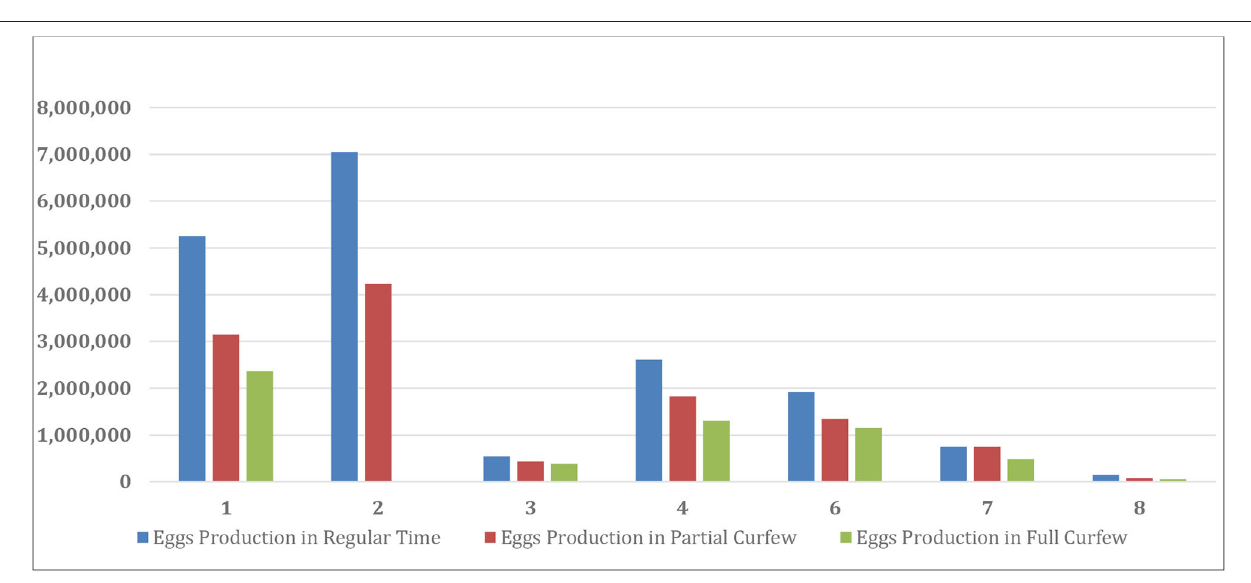
FIGURE 2 | Eggs production (tray/year) before and after SARS-Con-V2